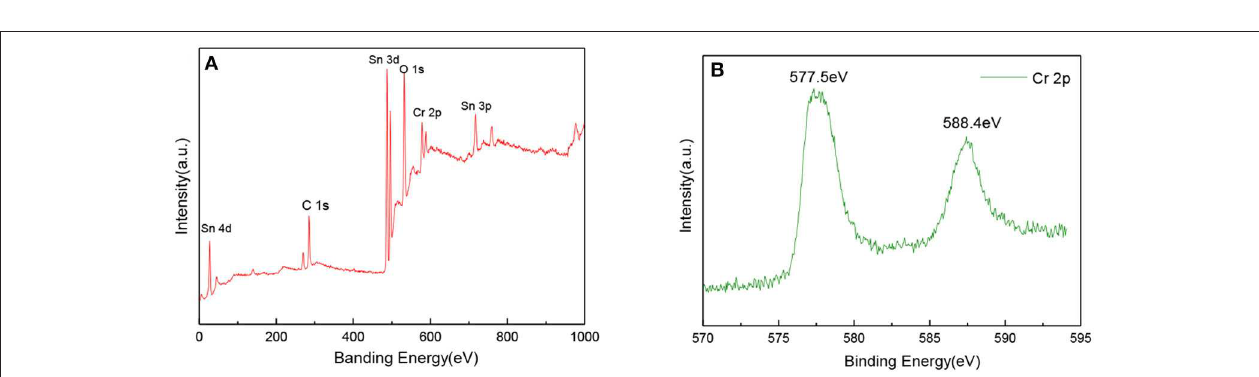
Frontiers in Materials |